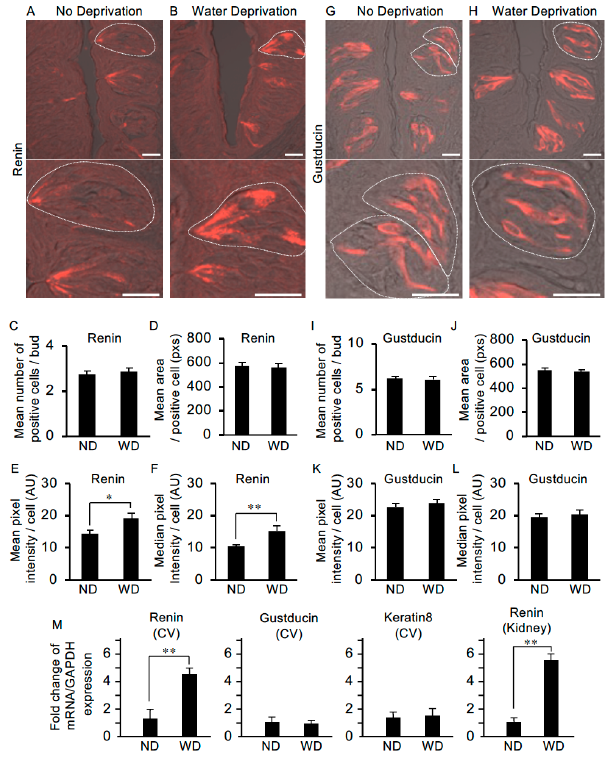
Figure 6. The level of renin expression in taste cells is upregulated after water deprivation. ( A ) In non-deprived (control) mice, renin was expressed at the apical process regions of taste cells and more weakly in the cell body regions (lower image: higher magnification of the upper image). ( B ) In mice deprived of water for 47 h, renin expression was observed throughout some cells, i.e., from apical to basal regions. Water deprivation did not change the mean number of renin-positive cells per taste bud [n = 28 taste buds from three non-water deprived mice (ND), n = 27 taste buds from three water-deprived mice (WD)] ( C ) or the mean area of renin-positive cells (n = 28 taste cells from ND, n = 28 taste cells from WD) (pixels: pxs) ( D ). However, significant di ff erences were detected in the mean pixel intensity ( E ) and median pixel intensity ( F ) of renin-positive cells (arbitrary unit: AU). Gustducin immunoreactivity was detected throughout positive cells from the apical to the basal regions in both non-water-deprived mice ( G ) and water-deprived mice ( H ). Water deprivation did not change the mean number of gustducin-positive cells per taste bud (n = 23 taste buds from ND, n = 23 taste buds from WD) ( I ), mean area of gustducin-positive cells (n = 32 taste cells from ND, n = 38 taste cells from WD) (pixels: pxs) ( J ), mean pixel intensity of gustducin-positive cells ( K ) or median pixel intensity ( L ) of gustducin-positive cells (arbitrary unit: AU). ( M ) Quantification of mRNA expression of renin, gustducin and keratin 8 by real-time PCR in the circumvallate taste papilla (CV) and Kidney (as the control tissue for renin expression) from ND and WD. Data were obtained from at least three independent experiments (n = 3–7 mice) per group each PCR assays were performed in triplicate. The quantitative PCR results were normalized using the ∆∆ Ct method with GAPDH (glyceraldehyde-3-phosphate dehydrogenase) in each sample as the reference, and shown as fold change of mRNA expression compared to ND. * p < 0.05, ** p < 0.01 for comparisons between ND and WD groups (Student’s t-test). All data are presented as the mean ± standard error of the mean. Dotted lines indicate the outlines of taste buds: scale bar, 25 µ